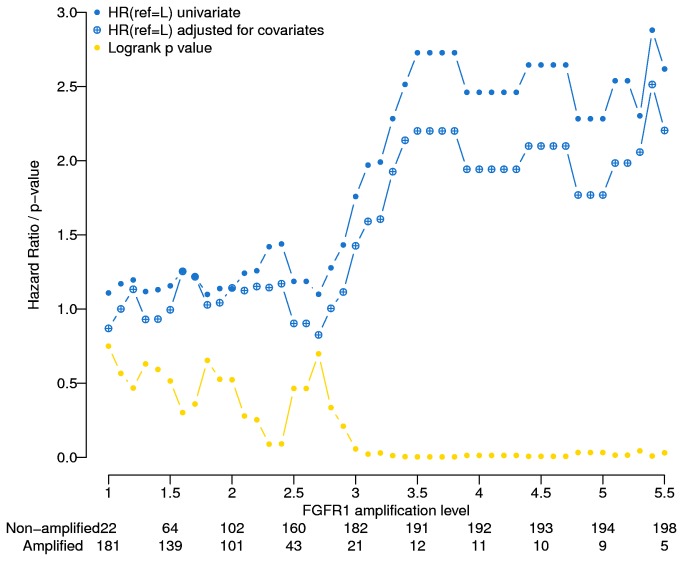
Exon 15 cutoff points and hazard ratio for death in the training cohort.